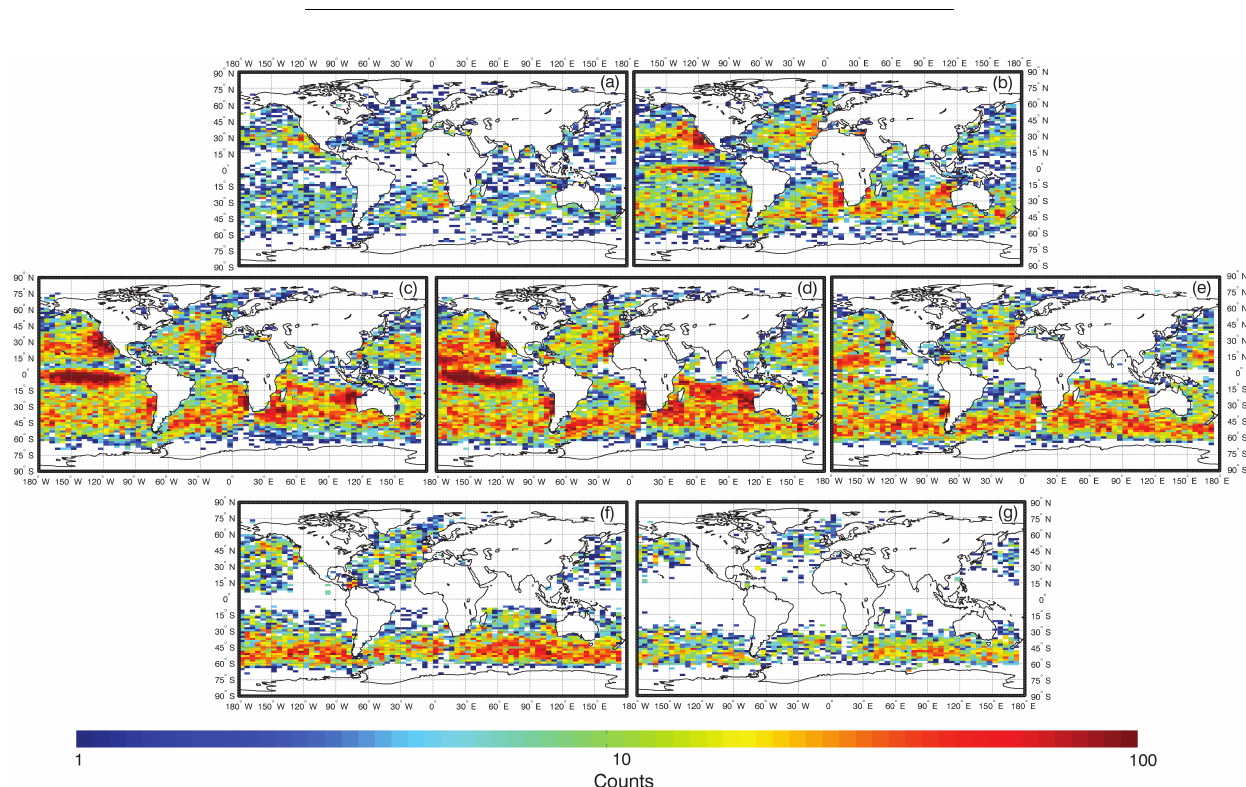
Figure 3. SODA/CALIOP retrieval counts for each 2 ◦ × 5 ◦ latitude longitude grid cell and different wind speed regimes. AMSR-E wind speed regimes for figures (a) through (g) , are 0–4, 4–6, 6–8, 8–10, 10–12, 12–15, and > 15ms − 1 ,